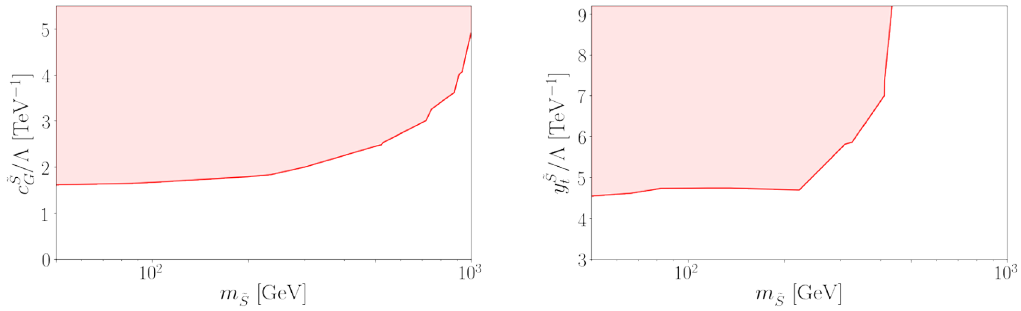
Figure 12 . Exclusion limits from the ATLAS mono-jet search [55] in the m ~ m ~ (cid:0) y ~ S plane (right) for the pseudoscalar mediator. In both cases y ~ t S other couplings are equal to